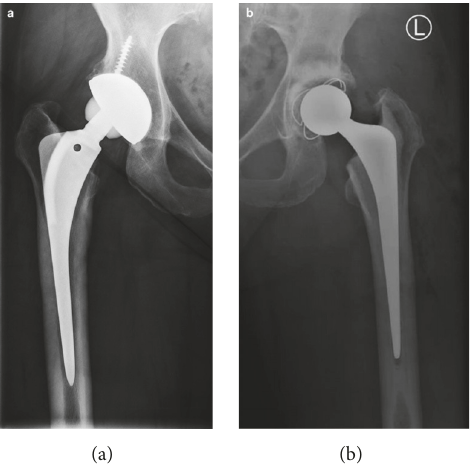
Figure 5: (a) Uncemented total hip replacement (THR) with a ceramic on ceramic bearing. (b) Cemented THR using the Exeter system with a metal on plastic bearing